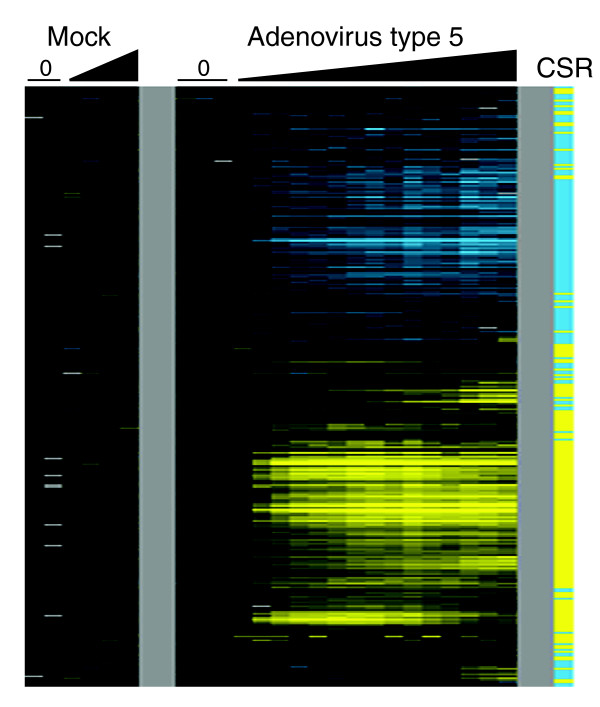
Induction of the core serum response by Ad5 infection. The responses of the core serum response (CSR) genes to adenovirus type 5 (Ad5) infection were isolated and clustered on the basis of their response to Ad5 infection. The serum dependent expression responses are summarized in yellow or blue (activated or repressed, respectively) in the rightmost column labeled CSR. Ramps above panels indicate increases in time after infection.